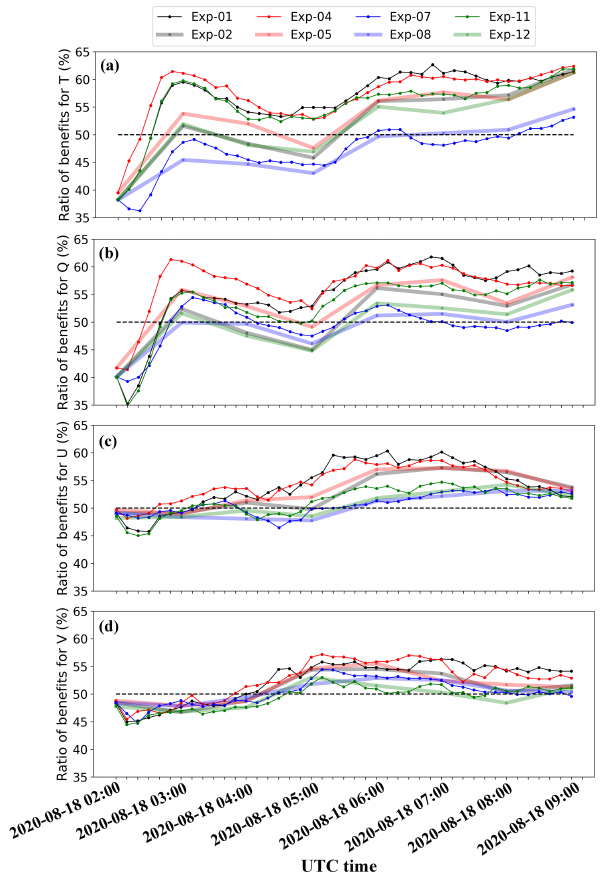
Figure 11. Time evolution of the ratio of beneficial impact , cal- culated by Eq. (15) for the first-guess forecast and analysis of (a) the perturbation potential temperature, (b) the water vapor mixing ratio, (c) the x -wind component, and (d) the y -wind component.